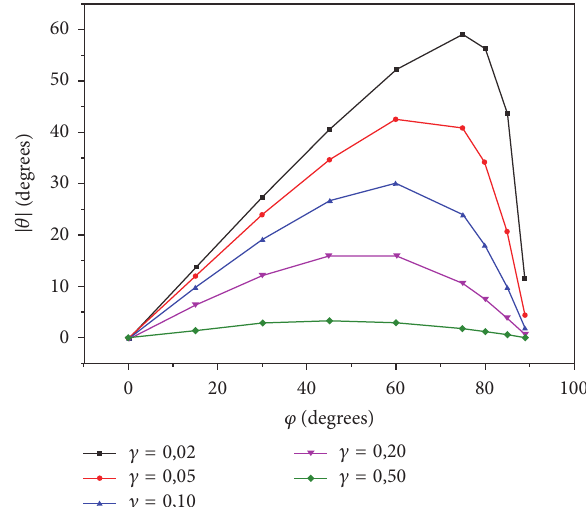
Figure 2: Dependence of the electric field bending angle |𝜃| on the layers’ orientation angle 𝜑 at five different values of the resistivity ratio 𝛾 = 𝜌 2 /𝜌 1